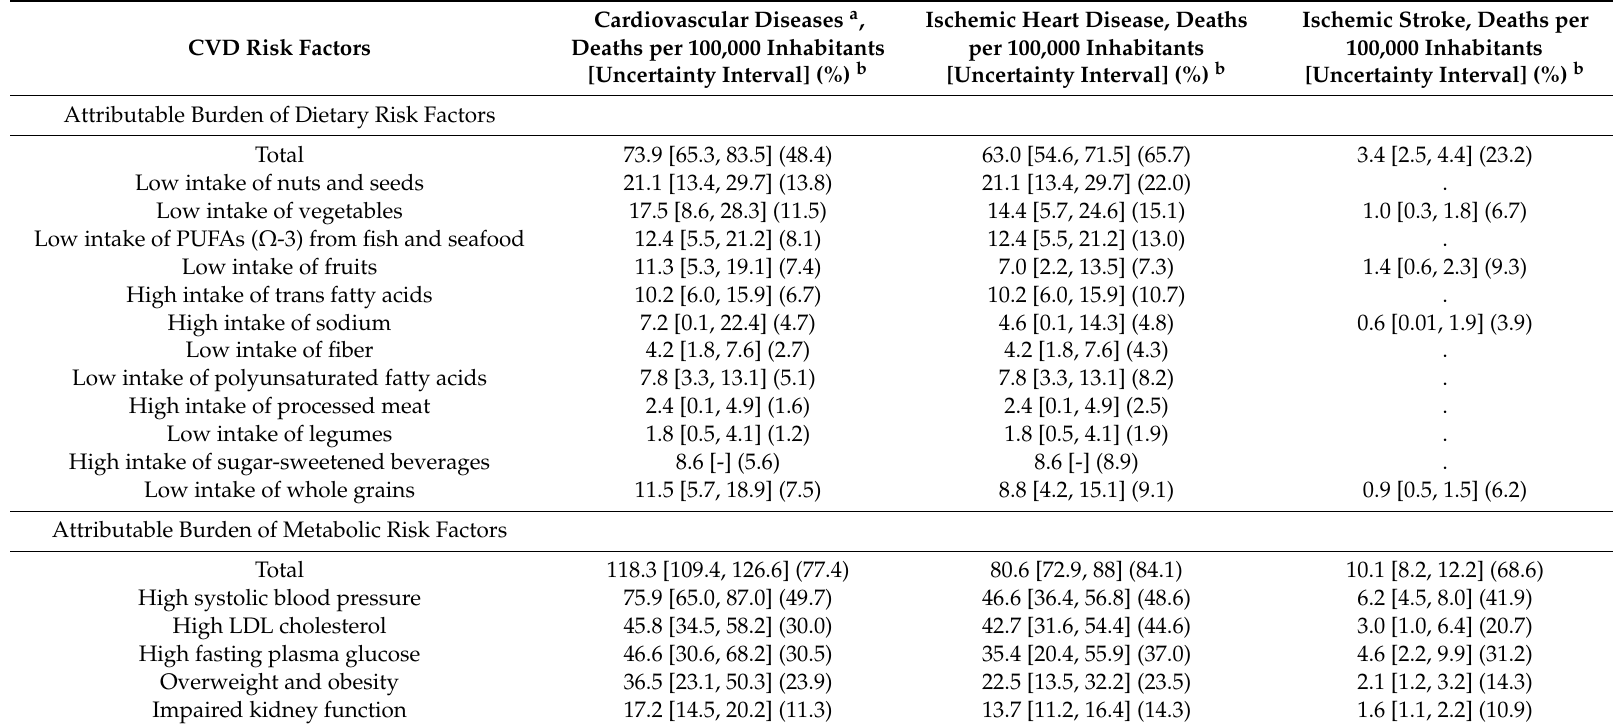
Table 4. Age-standardized deaths of CVDs attributable to risk factors in Mexico,